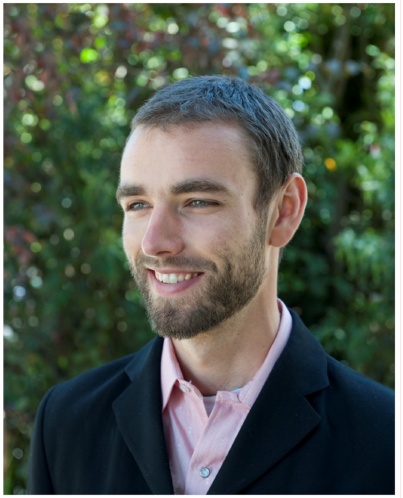
Figure 1. Whitney Dafoe Before Severe